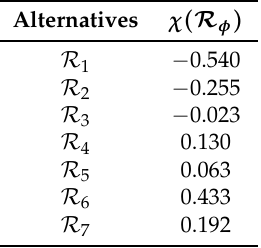
Table 12: Net flow of alternatives